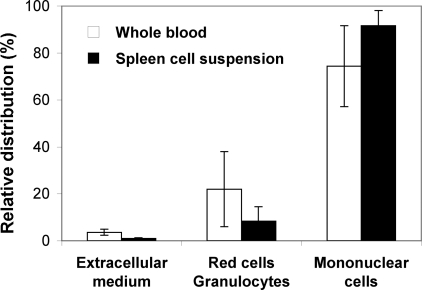
Mycolactone targets mononuclear cells in blood and spleen cell suspensions.The distribution of mycolactone in the gradient density fractions of whole blood or spleen cell suspensions is shown. Mycolactone was added to whole blood (20 µg/ml) or spleen cell suspensions (20 µg/spleen) and incubated for 4 h or 1 h, respectively. The amount of mycolactone distributing in each gradient fractions was then determined by ESI-LC-MS quantitative analysis of their acetone-soluble lipid extracts. Data are mean percentages and SD of duplicate measurements, and are representative of two independent experiments.